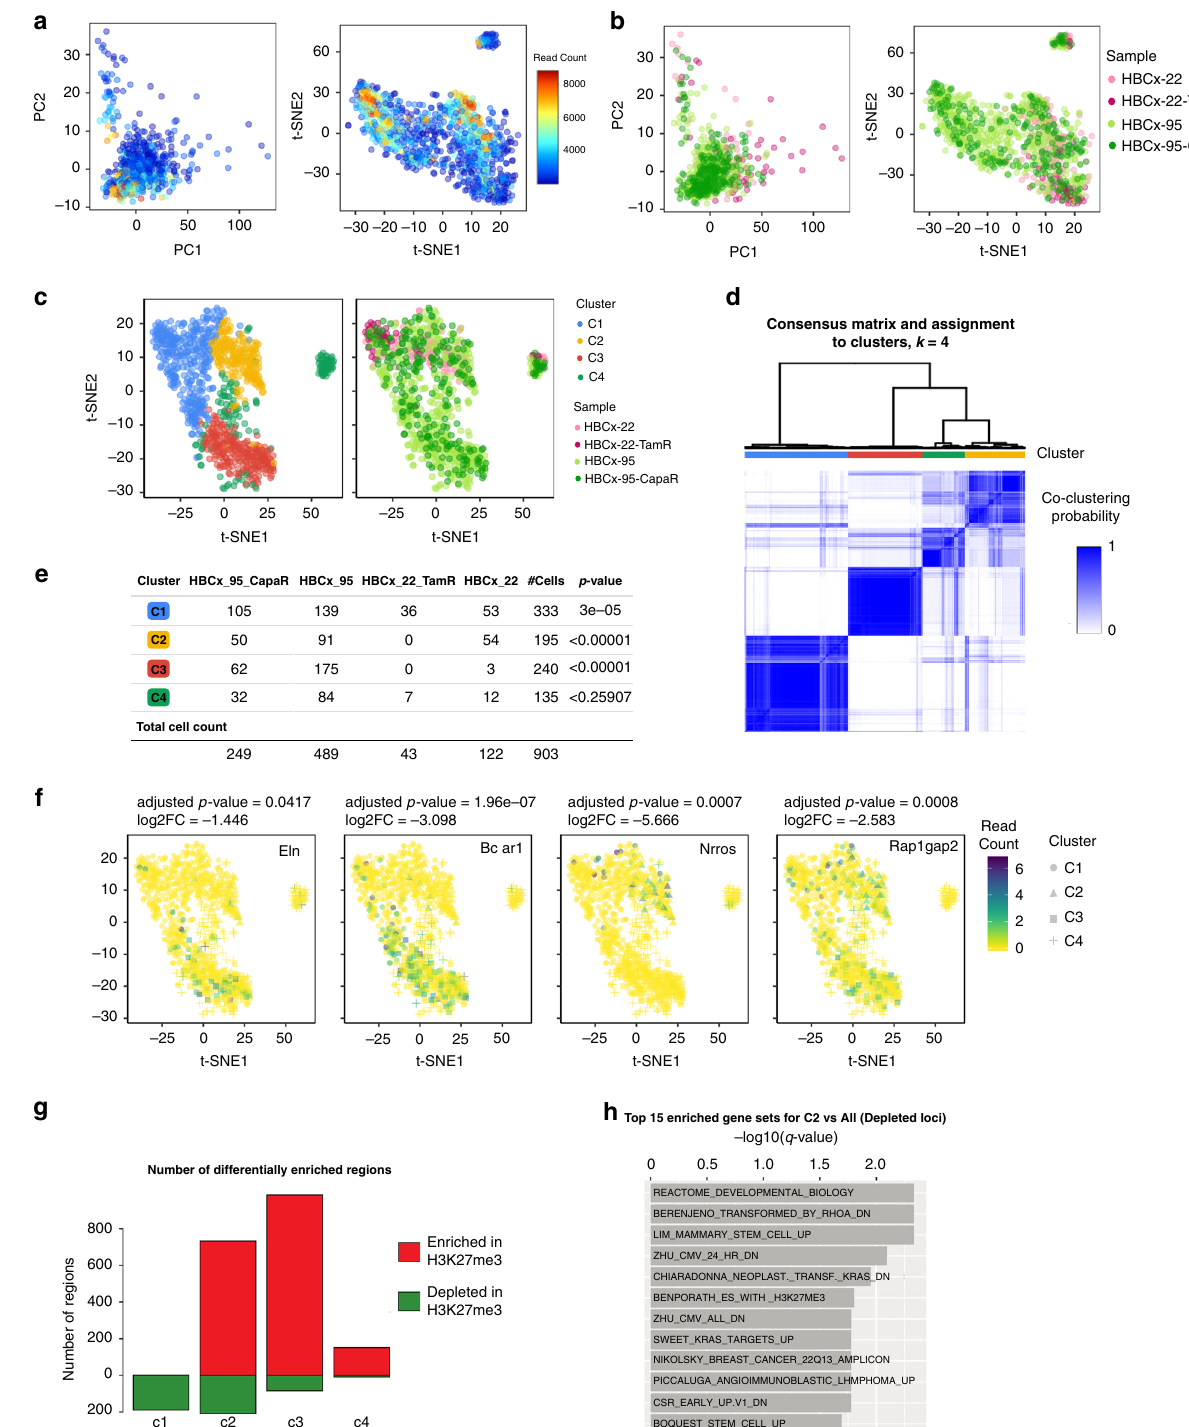
Top 15 enriched gene sets for C2 vs All